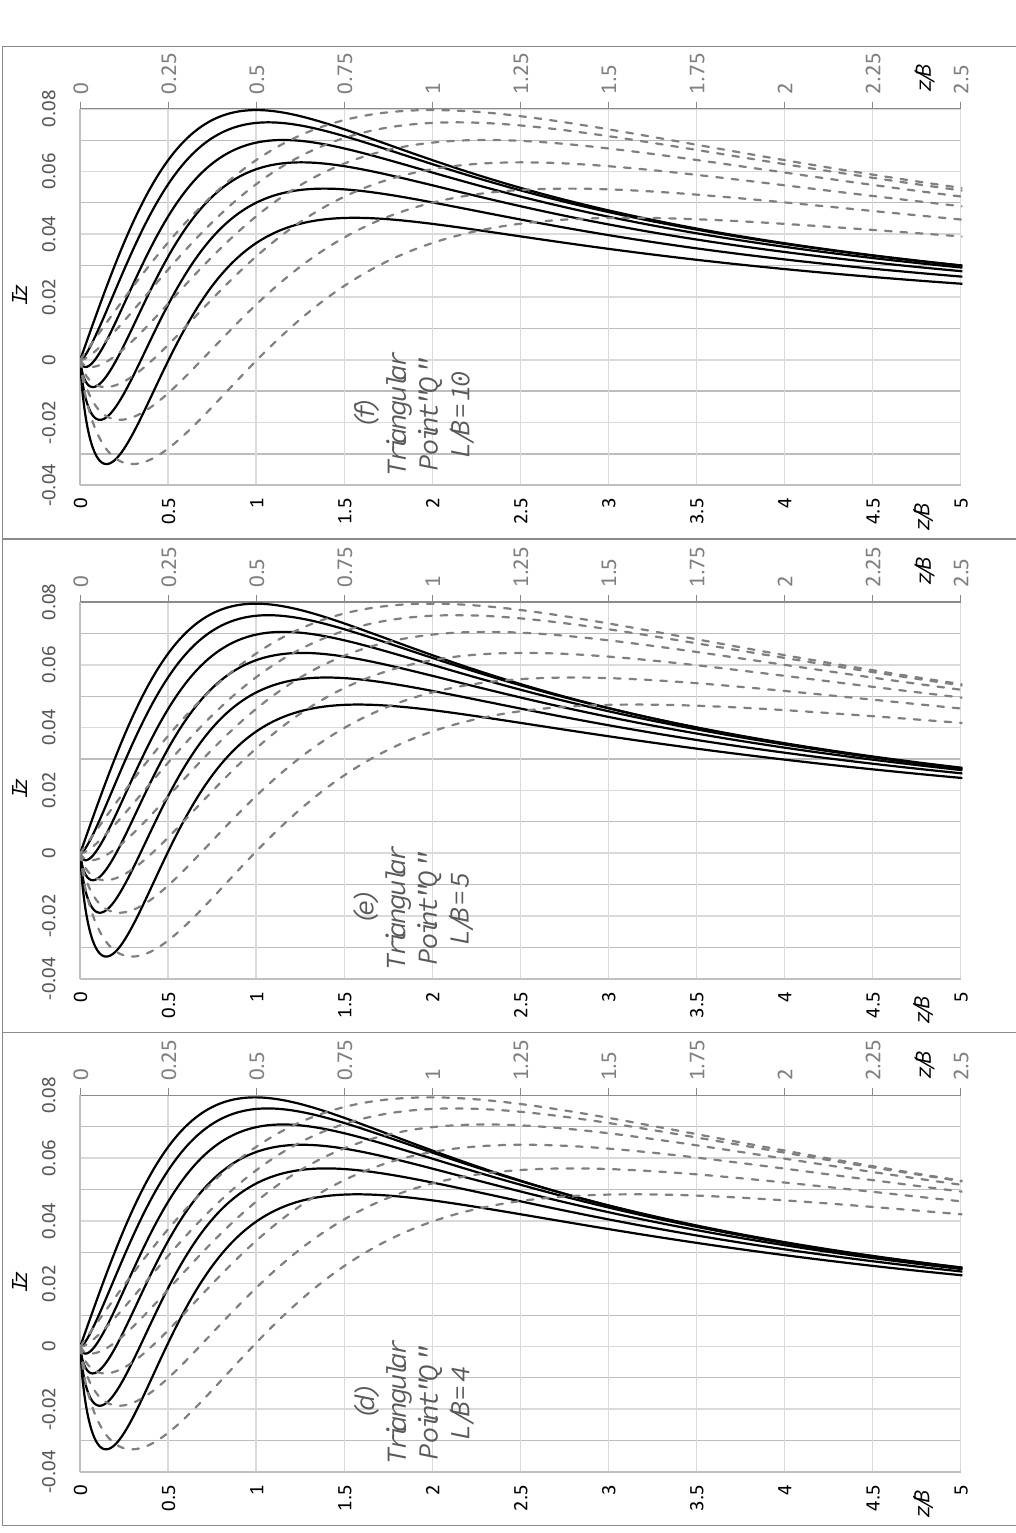
Figure 7. I z versus normalized depth charts referring to point “Q” of the triangular embankment loading of Figure 8b for various ν values; ν ranges from 0.5 to 0 (left to right) with 0.1 interval.